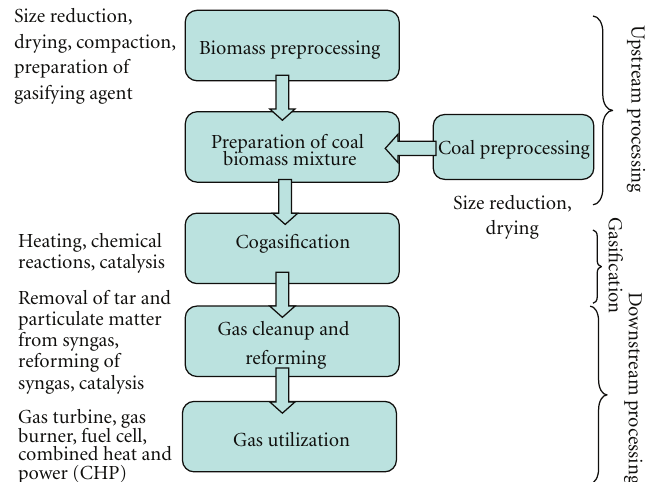
Figure 1: Various operations involved in the coal-biomass gasification